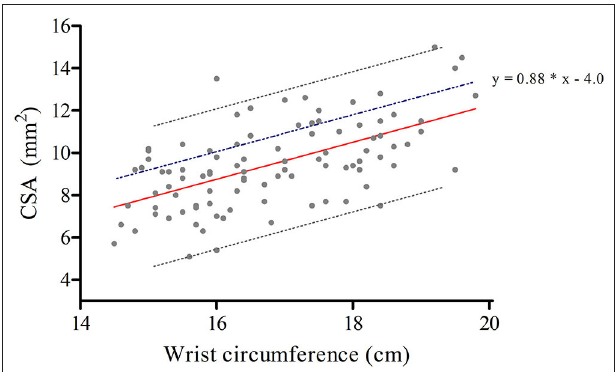
FIGURE 1 | Regression analysis of the 96 healthy controls for determining the upper limit of normal (ULN) of the cross-sectional area depending on wrist circumference. Regression equations for median values (0.88 * x − 5.25, red line), and for the upper limit of normal (0.88 * x − 2.0, grey upper dashed line); x being the wrist circumference. The blue dashed line represents our optimised equation for the new ULN (y = 0.88 * x − 4.0), adding 1.24 for each y.